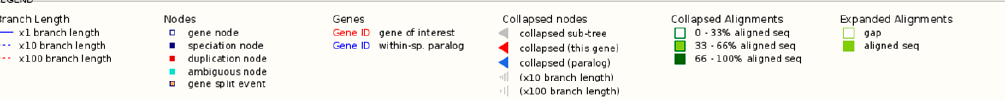
Figure 3. Gene tree for human CYP2A6 , 2A7 , 2A13 , 2B6 , 2C8 , 2C9 , 2C19 , 2D6 , 2D7 , 2E1 , 2F1 , 2J2 , 2R1 , 2S1 , 2U1 , and 2W1 built using Ensembl 84. These CYP2 family genes are paralogs to each other derived from the same ancestral gene via duplication events. The gene tree includes a total of 1254 genes from various species. The total number of speciation nodes is 741, and the number of duplication is 483. The number of ambiguous nodes is 29, and there is no gene split event. CYP2A7 is a hepatic enzyme, but its substrate specificity is unclear. The gene is located about 25 kb upstream of CYP2A6 . It maps to chromosome 19q13.2 consisting of 9 exons. In NCBI HomoloGene 68, CYP2A7 has 14 homologs in 6 species including human CYP2A6 and 2A13 , Rhesus monkey CYP2A24 , mouse Cyp2a4 and 2a5 , rat Cyp2a3 , etc. Based on NCBI Annotation Pipeline, 2 organisms have orthologs with CYP2A7 , namely pig-tailed macaque and pygmy chimpanzee. In Ensembl 84, CYP2A7 has 71 orthologs from 50 species of chordates including 7 species of non-human